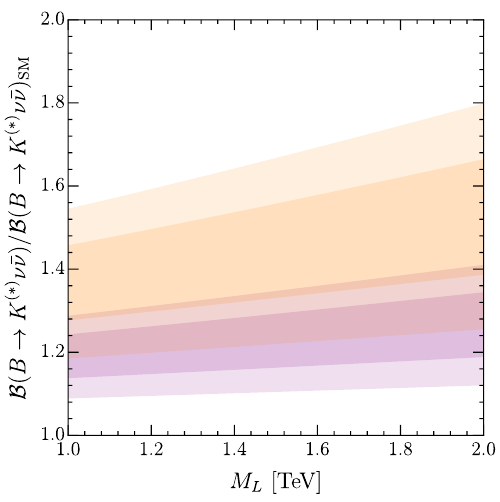
Figure 12 . Model predictions (best 1 σ and 2 σ fit regions) for the B → K ( ∗ ) ν ¯ ν branching ratio as a function of M degrees of freedom and the Z 0 mass in the M the other plots, orange and purple correspond to the benchmarks β bτ